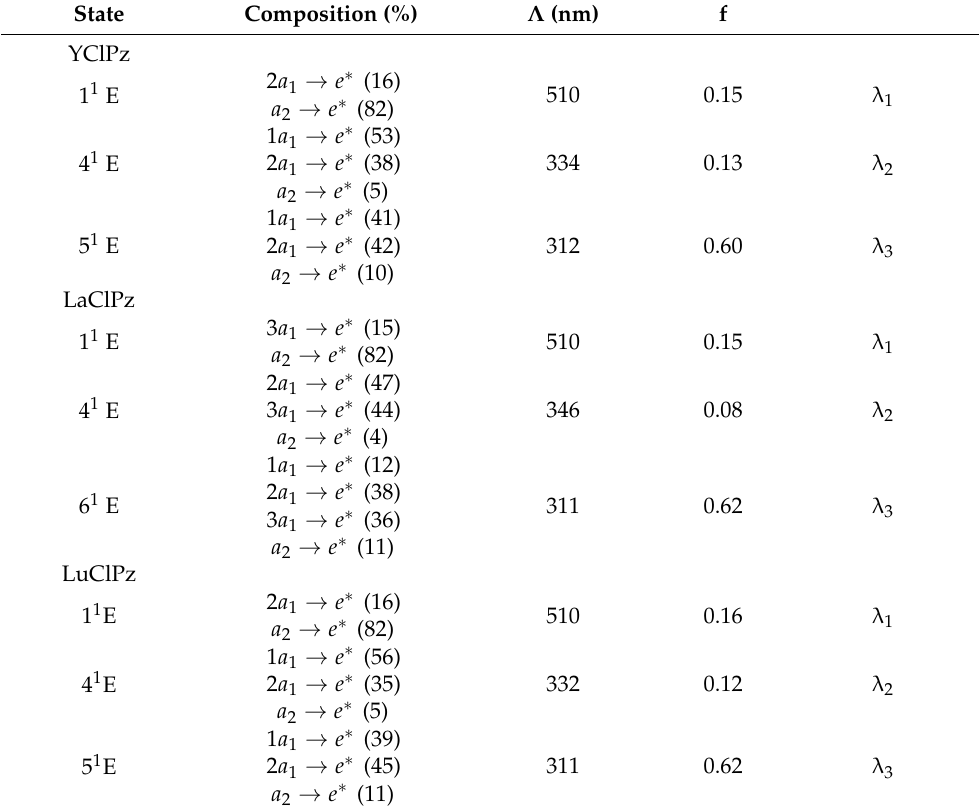
Figure 2. Calculated time-dependent density functional theory (TDDFT) electronic absorption spectra for MClPz ( a ) and MClTTDPz ( b ) complexes. Table 3. Calculated mposition of the lowest excited states and corresponding oscillator strengths for MClPz and MClTTDPz complexes.